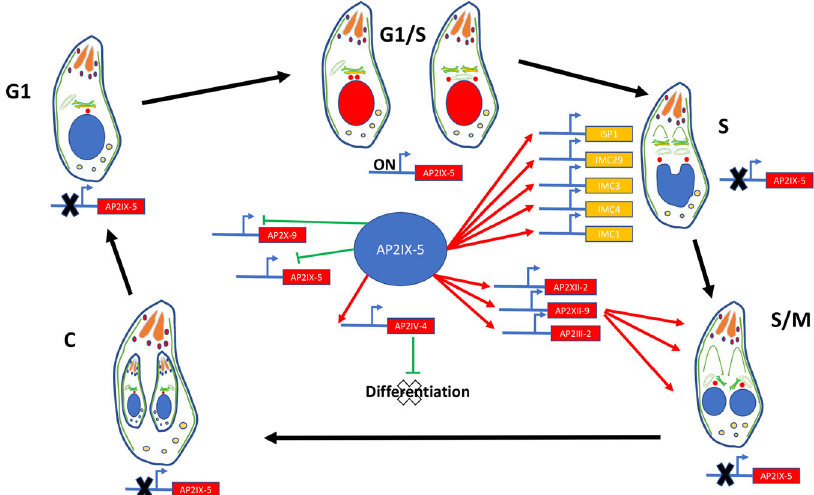
Fig. 7 Schematic representation of the effect of TgAP2IX-5 depletion on daughter cell formation according to the different phases of the cell cycle. Absence of TgAP2IX-5 leads to the blockage of the cell cycle within the G1/S phase. This is associated with the direct targeting of key inner membrane complex proteins such as TgISP1, TgIMC1, TgIMC29, TgIMC3, and TgIMC4 as well as other key TFs (TgAP2XII-2, TgAP2XII-9, TgAP2III-2, TgAP2IV-4, TgAP2X-9). TgAP2IV-4 is a known repressor of differentiation. TgAP2X-9 may be repressed by TgAP2IX-5. The TgAP2IX-5 transcript may also be regulated by a negative feedback